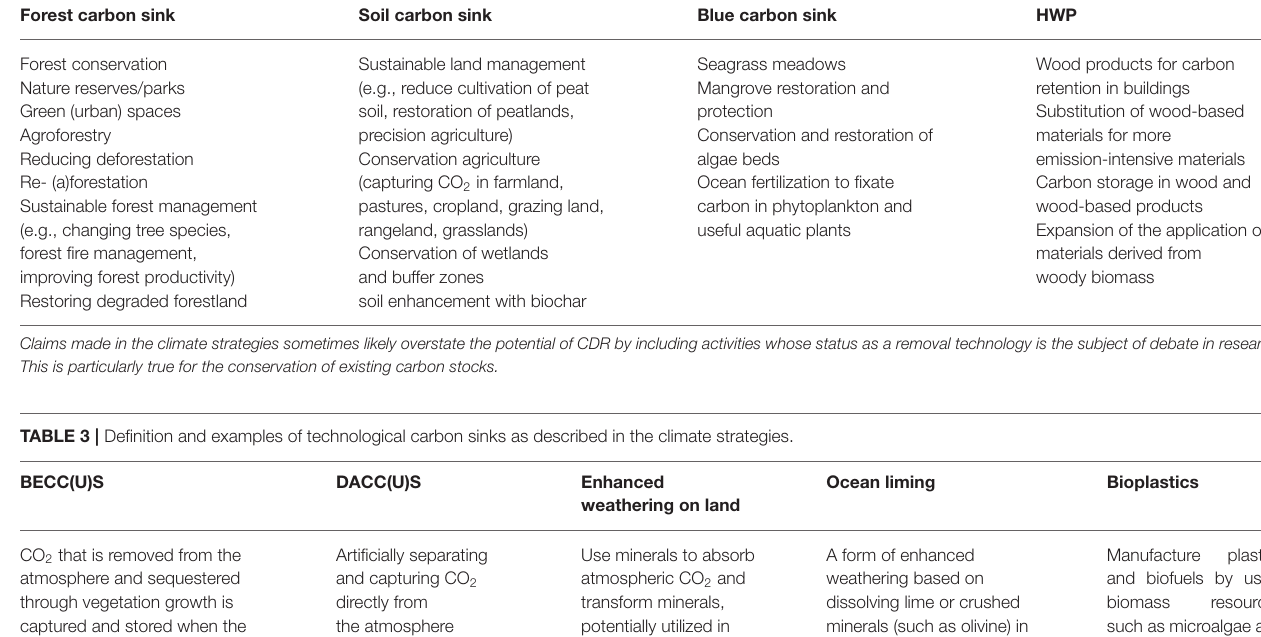
TABLE 2 | Examples of nature-based carbon sinks and measures for their maintenance or enhancement as described in the strategies. Forest carbon sink Soil carbon sink